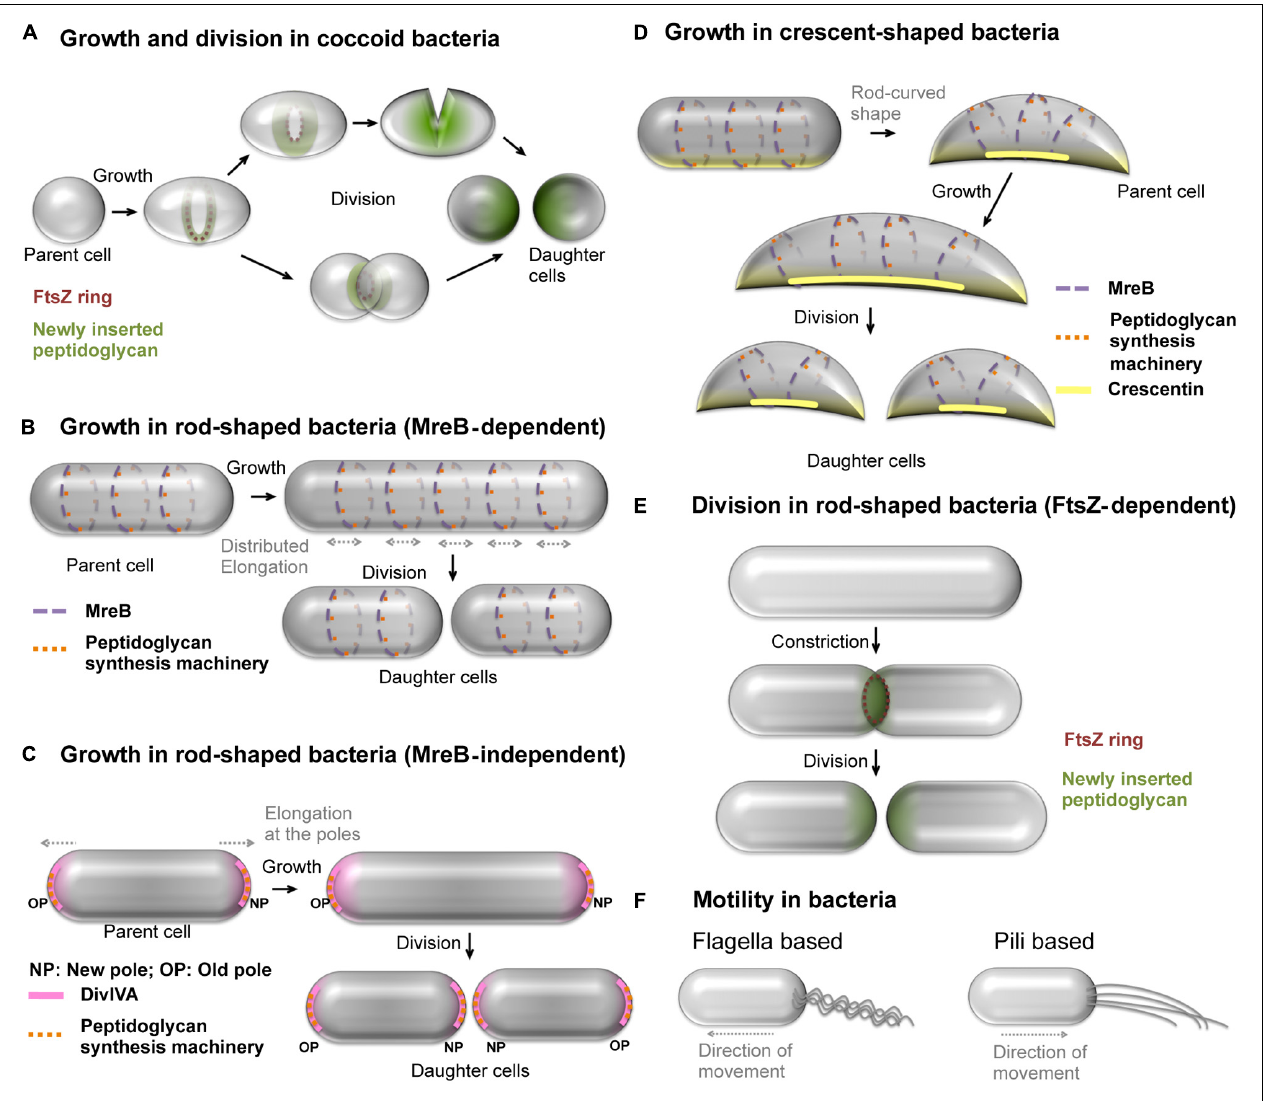
FIGURE 1 | Growth, cell division and motility mechanisms in bacteria. (A) Spherical, cell-walled bacteria grow and divide by insertion of peptidoglycan in FtsZ-dependent manner. Alternatively, some spherical bacteria divide by constriction. (B) Some of the rod-shaped, cell-walled bacteria such as E. coli grow uniformly along the length by uniform insertion of peptidoglycan facilitated by MreB patches and divide to produce daughter cells. The dark blue and light blue colors represent patches of MreB, and associated peptidoglycan synthesis machinery shown as red and pink dots, on the membrane at the front and back of the cell, respectively. (C) M. smegmatis , a cell-walled bacterium exhibits MreB-independent polar growth by positioning the peptidoglycan synthesis machinery (orange dots) with the help of DivIVA (pink) at the cell poles. (D) Caulobacter crescentus attains crescent shape by asymmetric growth using crescentin polymers (yellow line) that prevent peptidoglycan insertion at the site of their location. The crescentin polymers are positioned by MreB and the former prevents insertion of new peptidoglycan in its vicinity. The MreB patches present at locations away from crescentin facilitate cell growth, thus leading to crescent shape. (E) The most predominant mechanism of cell division by formation and constriction of FtsZ ring at the mid-cell region in cell-walled bacteria. The FtsZ-assisted insertion of peptidoglycan at the mid-cell region results into septum closure and separation of daughter cells. (F) Well studied motility mechanisms using appendages in cell-walled bacteria include the (i) flagella dependent swimming and (ii) type IV pili-based twitching motility. See Miyata et al. (2020) for a detailed review on motility mechanisms in